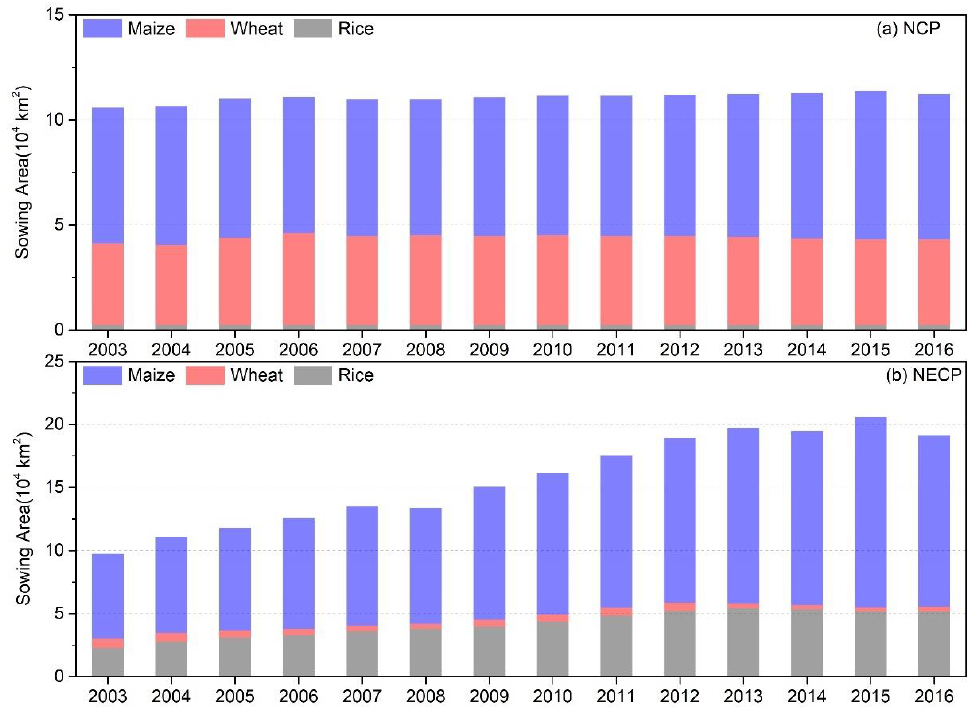
Figure 6. Stacking histogram of the sown area of main grain crops in the NCP ( a ) and NECP ( b ) from 2003 to 2016.